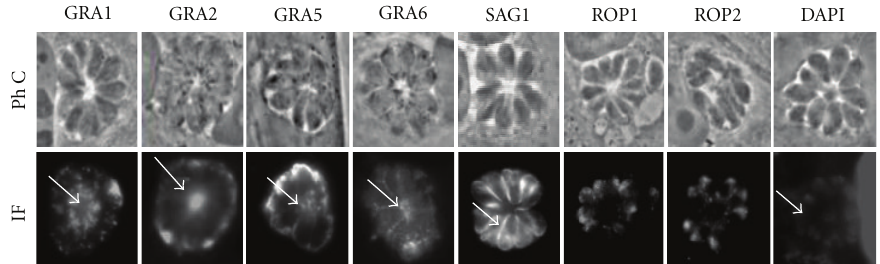
Figure 3: Localization of GRA proteins in the RB. MDCK cells infected with RH tachyzoites were incubated with antibodies directed against the dense granule proteins GRA1, GRA2, GRA5, and GRA6, rhoptry proteins (ROP1, 2), or membrane protein SAG1. GRA proteins marked the RB (arrows), while the stain with nuclear marker, DAPI, showed a weak staining of RB. Immunofluorescence micrographs (IF) are shown with their respective phase contrast microscopy images (PhC).